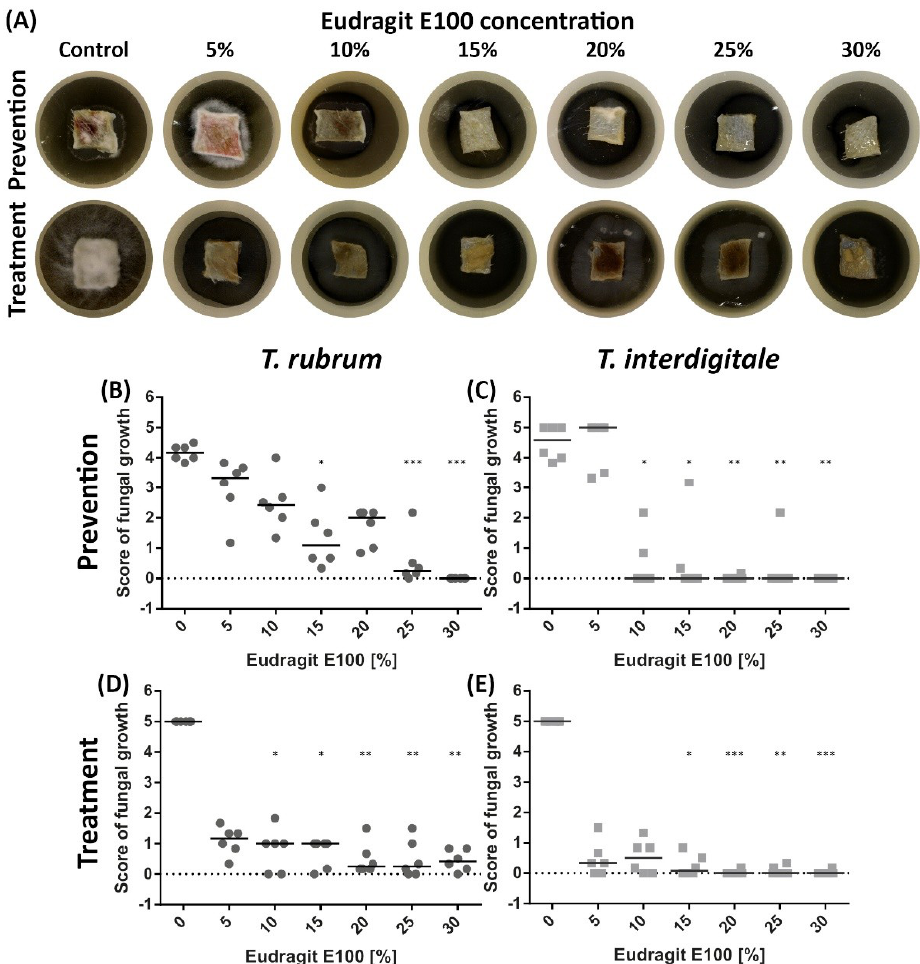
Figure 2. Effect of Eudragit (5–30%) on the ex vivo fungal growth of T. rubrum and T. interdigitale in prevention and treatment tests. ( A ) Representative images of fungal growth on porcine skin to which Eudragit was applied before inoculation with T. rubrum (prevention) or treated with Eudragit 3 days after inoculation with T. rubrum (treatment). Panels ( B – E ) show the median score values of fungal growth (Table 1): ( B ): Prevention of T. rubrum growth; ( C ): Prevention of T. interdigitale growth; ( D ): Treatment of T. rubrum infected skin; ( E ): Treatment of T. interdigitale infected skin. Statistical analysis was performed using a Kruskal-Wallis ANOVA followed by Dunn’s post hoc test: n = 6/group: * p < 0.05, ** p < 0.01, *** p < 0.001 vs. control. To visualize the effect of the polymers, a Live/Dead stain was used on microconidia that were incubated for 72 h, using the DNA-binding dyes SYTO9 and NucFix Red to distinguish between living (green) and dead (red) cells. Unfortunately, this technique did not work with Eudragit due to the high autofluorescence and/or binding of the fluorescent dyes to the polymer, so only results for ABIL are shown (Figure 5). In the absence of polymer, both Trichophyton spp. developed into mycelium with multinucleated hyphae (in green), which is characteristic of filamentous molds. In contrast, in samples treated with ABIL, the red colour of NucFix Red dominated, and most fungal material still had the appearance of microconidia. This indicated that most conidia did not germinate, had damaged membranes, and were therefore probably dead. In the presence of 15% ABIL, some conidia with germ tubes could be seen with T. rubrum , but with 20% or 25% ABIL these germ tubes disappeared, even though some microconidia still appeared alive. With T. interdigitale , any level of ABIL tested resulted in the complete killing of microconidia, as demonstrated by the absence of any green